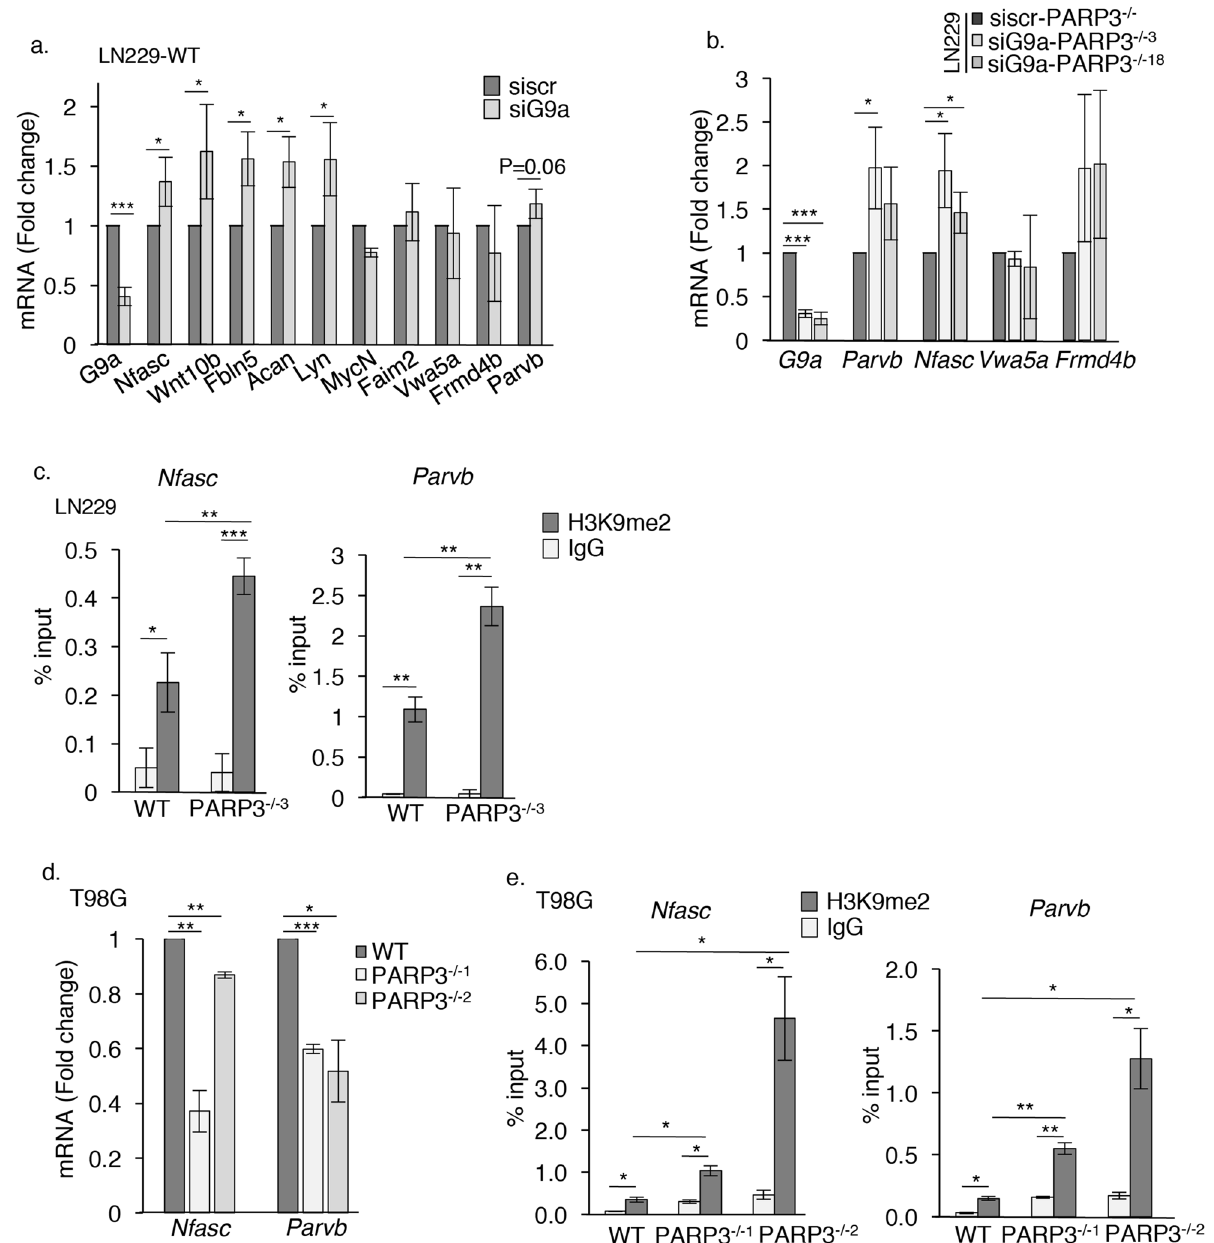
Figure 4. PARP3 moderates the G9a-mediated repression of the adhesion genes Nfasc and Parvb. ( a ) The silencing of G9a increases the expression of Nfasc , Wnt10b , Fbln5 , Acan , Lyn . The parental LN229 cells were transfected with either sicontrol or siG9a for 72 h. The ECM ( Wnt10b , Fbln5 , Acan , Lyn ), adhesion/junction ( Nfasc , Faim2 , Vwa5a , Frmd4b , Parvb ) and G9a mRNA levels were analysed by RT-qPCR. Data are expressed relative to Gapdh . Values represent means ± s.e.m. of 3 independent experiments and 3 technical replicates. *p < 0.05, ***p < 0.001. ( b ) Recovery of expression of Parvb and Nfasc in the PARP3-deficient cells upon G9a silencing. The PARP3 −/−3 and PARP3 −/−18 LN229 cells were transfected with either sicontrol or siG9a for 72 h. The transcript levels of G9a , Parvb , Nfasc , Frmd4b and Vwa5a were analysed by RT-qPCR. Data are expressed relative to Gapdh . Values represent means ± s.e.m of 3 independent experiments and 3 technical replicates. *p < 0.05, ***p < 0.001 ( c ) Increased enrichment of H3K9me2 on the promoters of Nfasc and Parvb genes in PARP3-deficient LN229 cells. H3K9me2 binding was assessed on the promoter regions of Nfasc , Parvb by CHIP-qPCR in the parental WT versus the PARP3 −/−3 LN229 cells. IgG were used as ChIP negative controls. Data are represented as percent of input and are means (± s.e.m) of three biological replicates. *p < 0.05, **p < 0.01, ***p < 0.001. ( d ) Repression of Nfasc and Parvb in PARP3-deficient T98G cells. The transcript levels of Parvb and Nfasc were analysed by RT-qPCR in WT, and PARP3 −/−1 and PARP3 −/−2 T98G cell lines. Data are expressed relative to Actin . Values represent means ± s.e.m of 3 independent experiments and 3 technical replicates. *p < 0.05, **p < 0.01, ***p < 0.001. ( e ) Increased enrichment of H3K9me2 on the promoters of Nfasc and Parvb genes in PARP3-deficient T98G cells. H3K9me2 binding was assessed on the promoter regions of Nfasc , Parvb by ChIP-qPCR in the parental WT versus the two PARP3 −/−1 and PARP3 −/−2 T98G cells. IgG were used as ChIP negative controls. Data are represented as percent of input and are means (± s.e.m) of three biological replicates. *p < 0.05, **p <